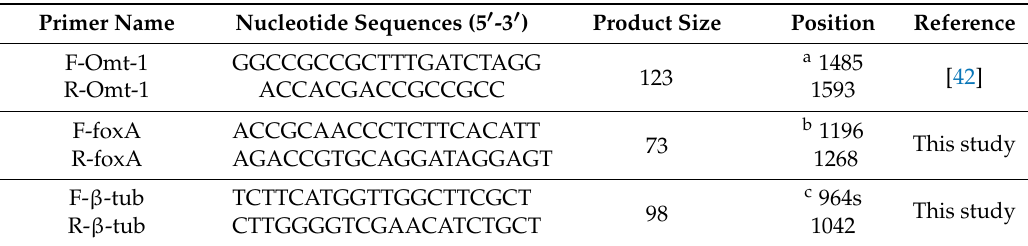
Table 1. Nucleotide sequence of primers used for the quantitative polymerase chain reaction (qPCR)